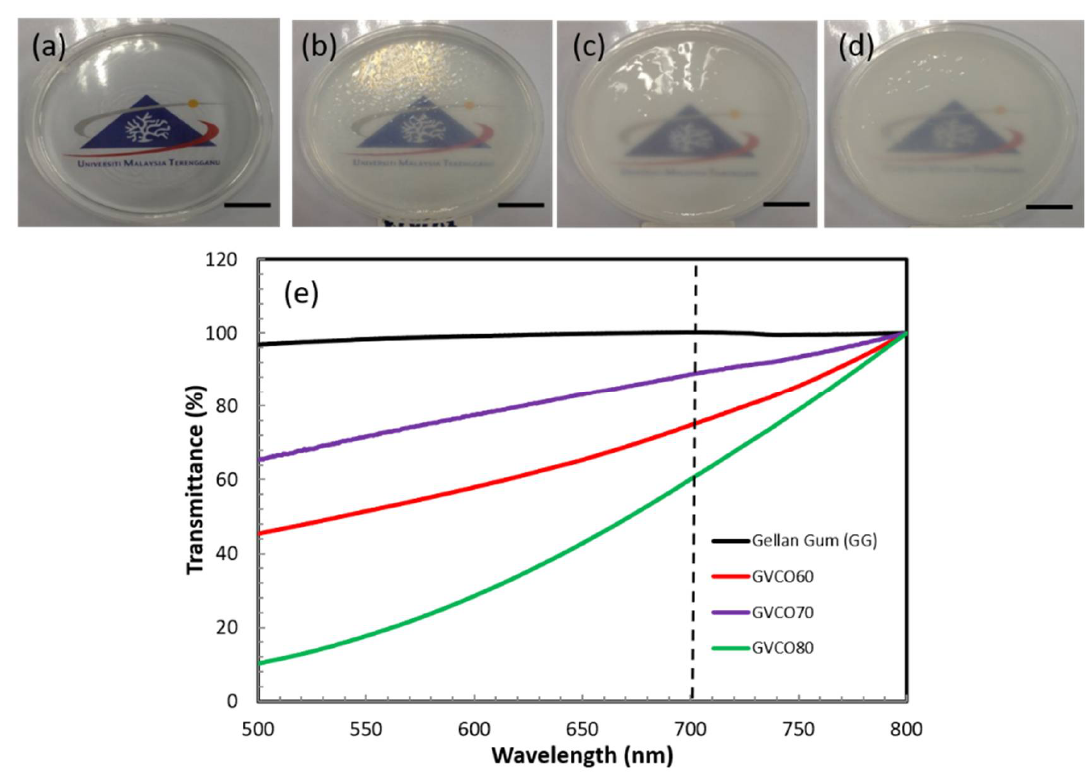
Figure 2. The physical appearance of ( a ) GG hydrogel, ( b ) GVCO60 ( c ) GVCO70, ( d ) GVCO80 hydrogels, and ( e ) transmittance of GG and GG–VCO hydrogels.